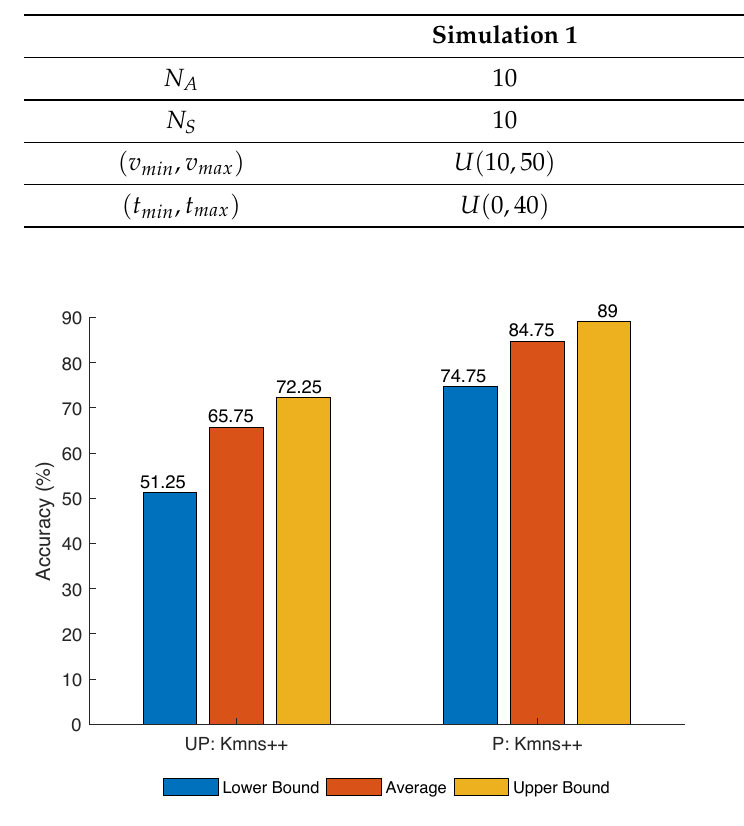
Table 2. Simulation parameters.